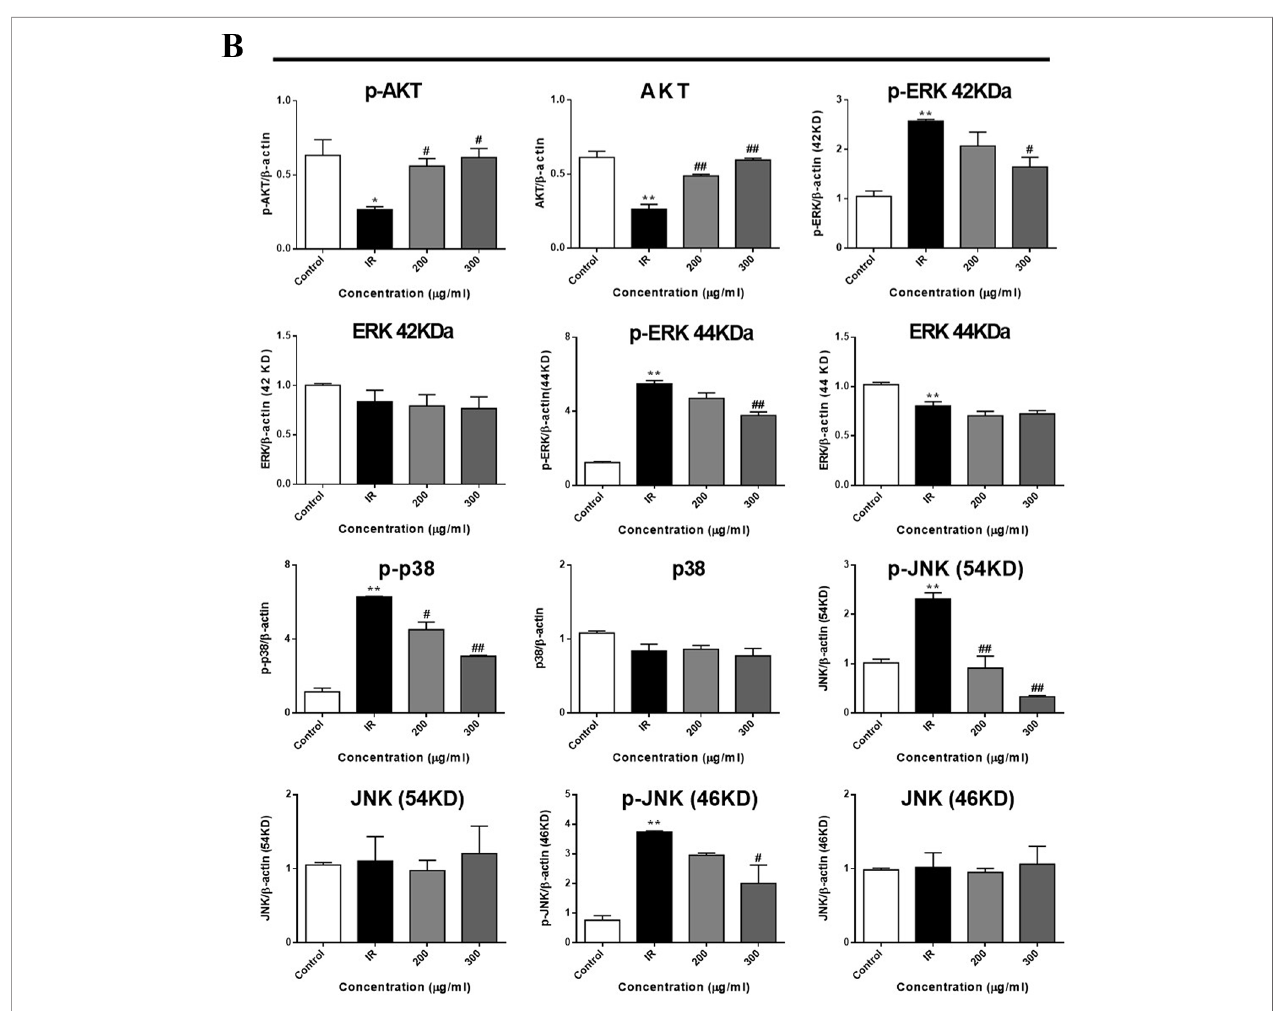
FIGURE 6 | WEE affected the molecular components of IRS1/GSK-3 b /FoxO1 pathways in PA treated HepG2 cells. HepG2 cells were incubated with normal glucose (5.5 mM) or high glucose (30 mM) plus PA (0.3 mM) in the absence or presence of WEE (200 and 300 m g/ml) for 24 h and followed by being stimulated with insulin (100 nM) for 20 min. Then, the phosphorylation and total levels of IR b , IRS-1, GSK3 b , CREB, c-Jun, FoxO1, Akt, p38, JNK, and ERK were detected by Western blotting. Bar graphs show the relative expression of indicated proteins. All proteins were normalized for b -actin levels. Data presented in bar charts are mean ± SEM values from three independent experiments. Groups are signi fi cantly different from the control group at *p < 0.05, **p < 0.01. The groups are signi fi cantly different from the IR group at # p < 0.05 and ## p < 0.01 determined by Dunnett ’ s multiple comparisons